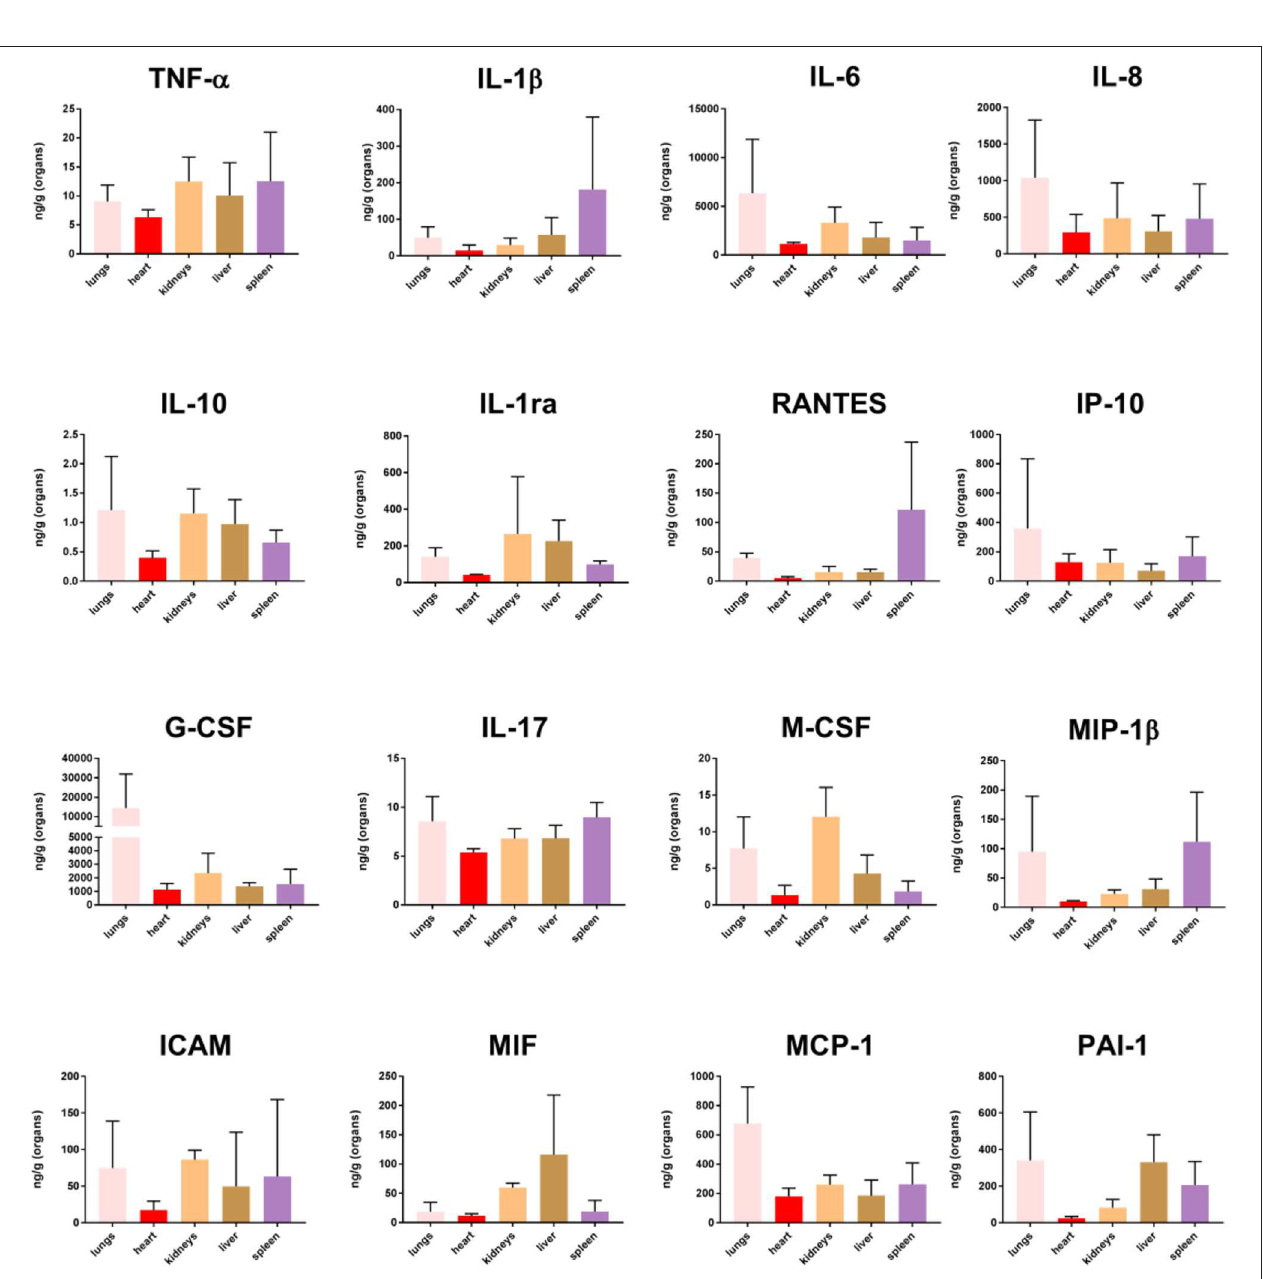
FIGURE 8 | Cytokine concentration in fresh frozen tissue samples from patients with meningococcal septic shock ( n = 3). The concentration unit is ng/g for the organ samples.